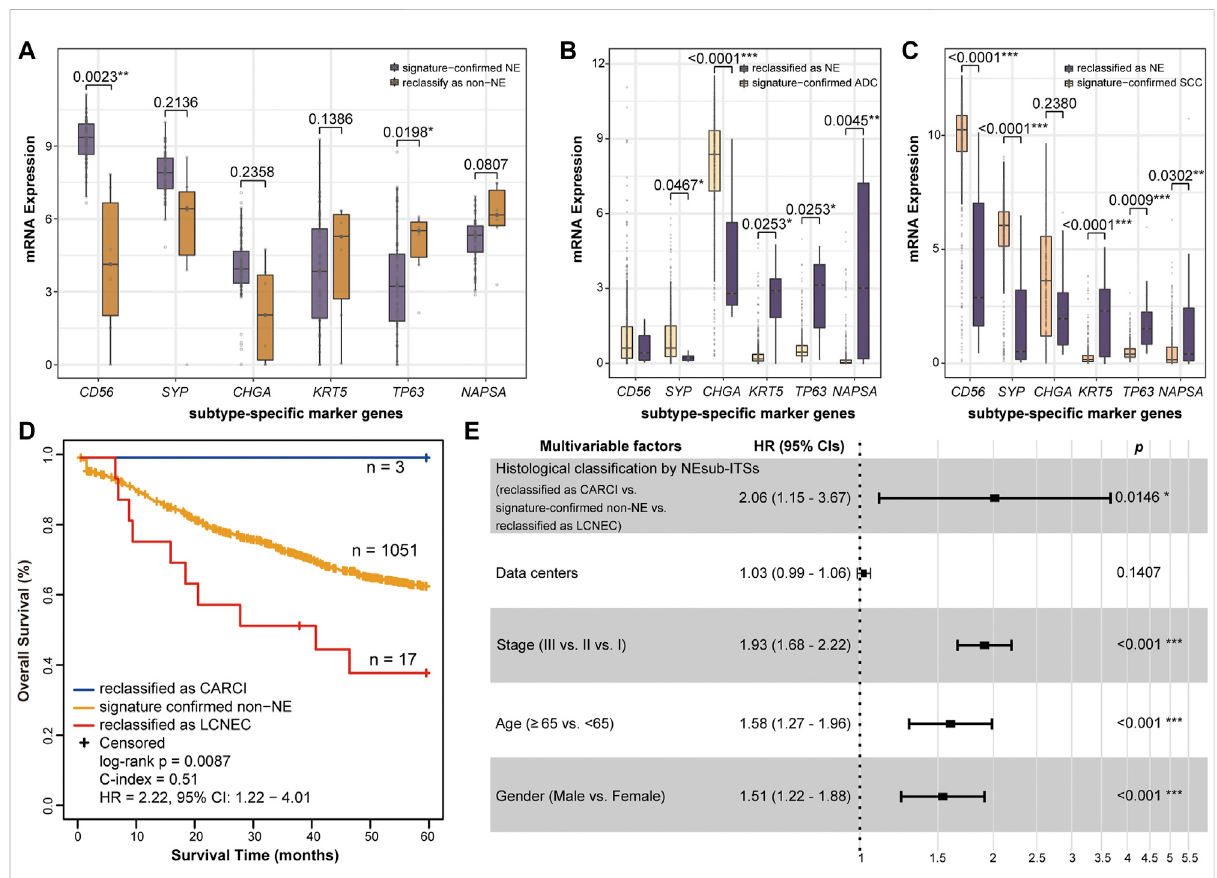
FIGURE 5 Biologicalanalysesofthereclassi fi cationoftheNEsubtype-panel.TheboxplotsofmRNAexpressionofthesubtype-speci fi cmarkergenesin (A) GSE60052, (B) TCGA-LUAD, and (C) TCGA-LUSC datasets with the most reclassi fi ed samples (6, 10, and 19 samples, respectively). The subtype- speci fi c marker genes include three neuroendocrine marker genes ( CD56 , SYP , and CHGA ), two SCC marker genes ( KRT5 and TP63 ), and one ADC marker gene ( NAPSA ). The RankProd algorithm was used to test the difference in the subtype-speci fi c marker genes between the reclassi fi ed samples and the signature-con fi rmed samples. (D) Kaplan – Meier curves of overall survival for the non-NE samples that were reclassi fi ed as CARCI (blue), signature-con fi rmed non-NE (yellow), and non-NE samples reclassi fi ed as LCNEC (red). (E) multivariate Cox regression analysis for histological classi fi cation by signatures after adjusting for data center and clinical parameters in the integrated dataset. NE, neuroendocrine; CARCI, carcinoids; ADC, adenocarcinoma; SCC, squamous carcinoma; and LCNEC, large-cell neuroendocrine